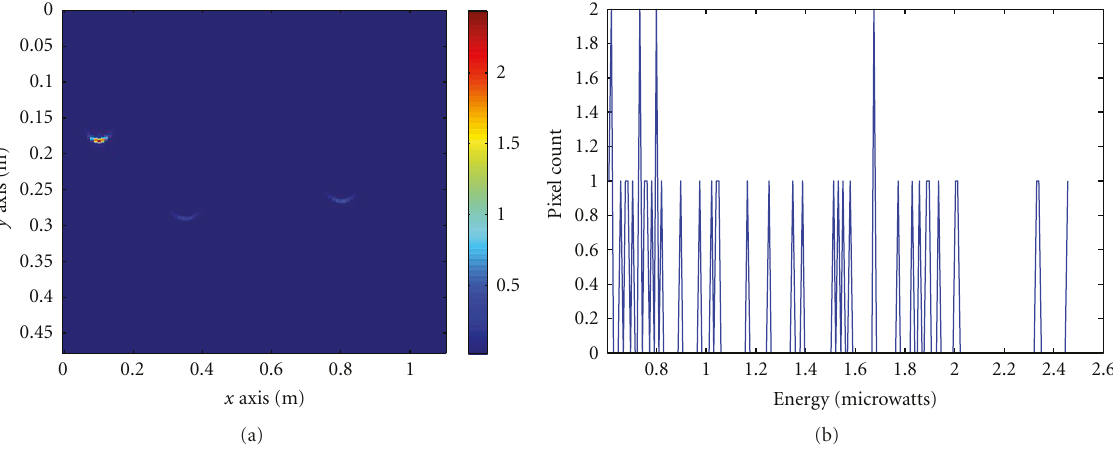
Figure 3: (a) Reconstructed data set using v = 1 . 2 v sim . (b) Image